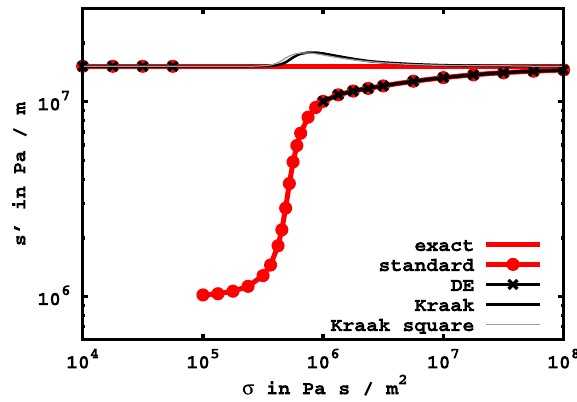
Figure 9. Dynamic stiffness per unit area s 0 : the exact value, the calculation according to [2] using the standard procedure, the calculation according to the German preamble of [3] (DE), and calculation according to Kraak (22) for circular and quadratic geometry.